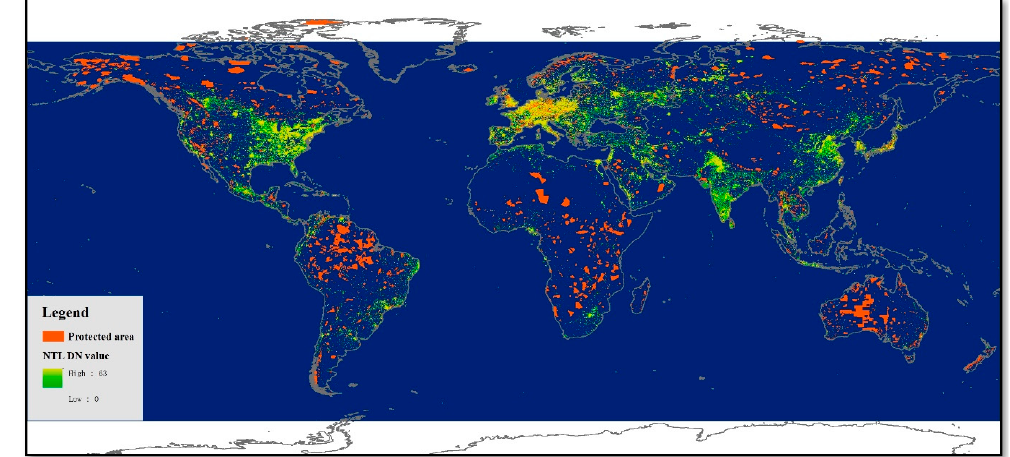
Figure 3. Spatial distribution of NTL in association with global terrestrial protected areas (PAs). The orange-colored areas represent the PAs; the dark blue-colored area (including oceans) were in darkness; the yellow-colored areas had a higher NTL digital number (DN) value than the green-colored areas; the white-colored area had no data.